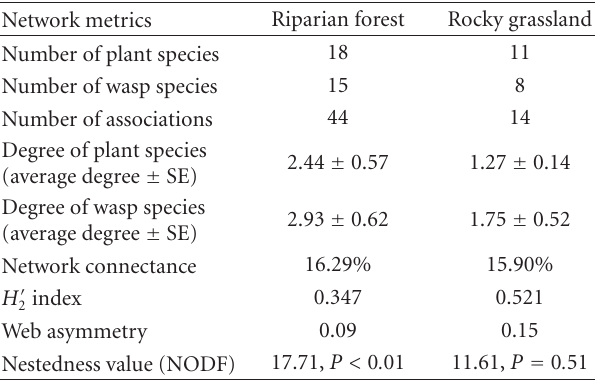
Table 1: Metrics of networks for the wasp-plant interactions studied at Ibitipoca State Park, MG, Brazil, during the period